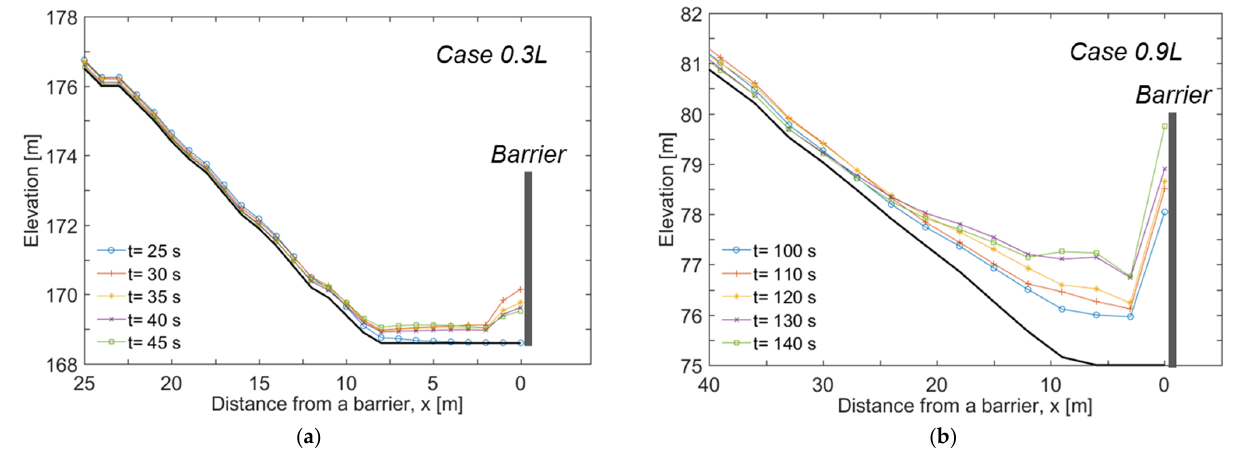
Figure 5. Debris depths near the vicinity of a barrier: ( a ) Case 0.3 L with no overflow and ( b ) Case 0.9 L with overflow.